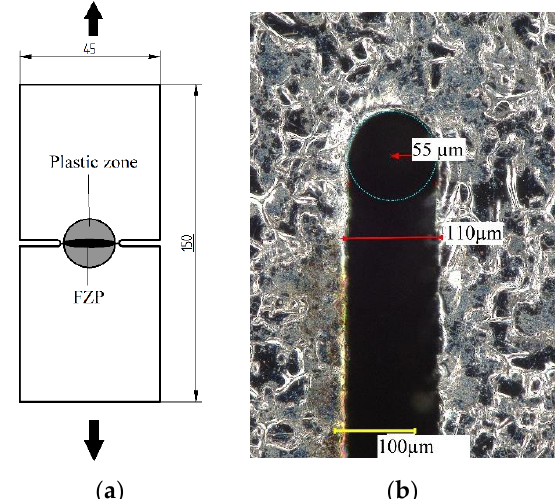
Figure 3. Double edge notched tension (DENT) specimen: ( a ) Schematic representation of the specimen (mm); ( b ) Notch tip geometries of the specimen (digital microscope).